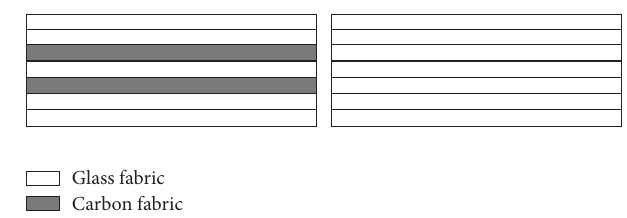
Figure 2: Structure of tested laminates.